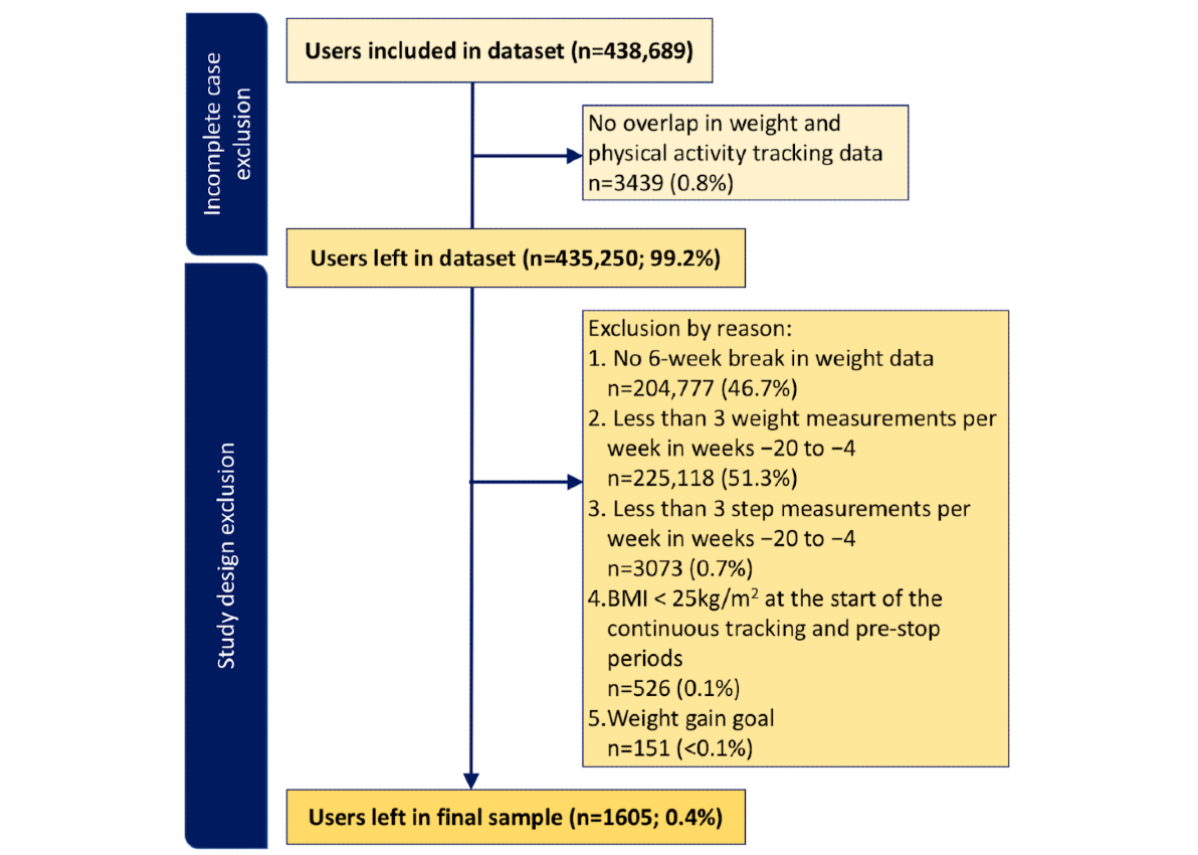
Figure 4. Flow diagram of the exclusion rates at each